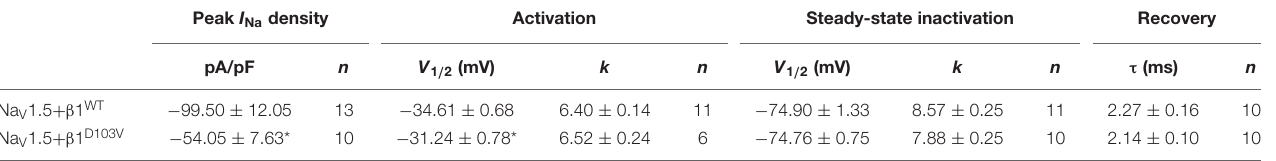
TABLE 3 | Biophysical parameters of HEK cells cotransfected with Na V 1.5 and β 1 WT or β 1 D103V . Peak I Na density Activation Steady-state inactivation Recovery